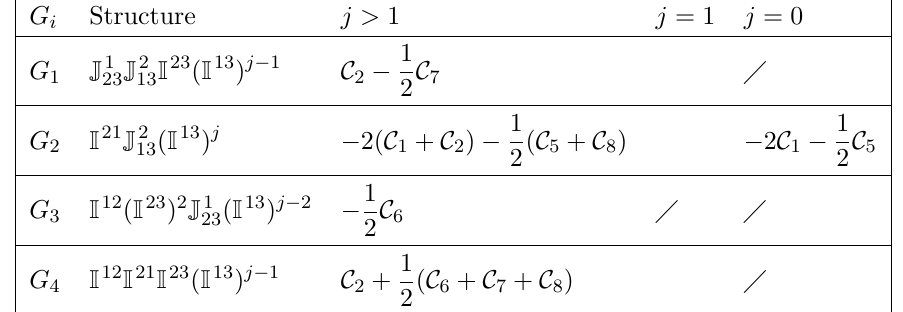
Table 14 . Expansion of the supersymmetric correlator in the component spin ( 1 ; 1 j ). The unbarred entries in the j = 1 column can be obtained by setting the 2 2